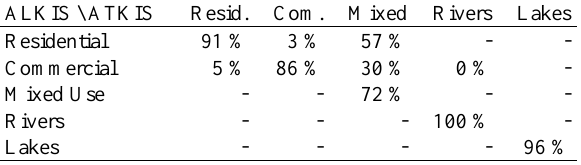
Table 2. Similarity matrix derived from the confusion matrix. The fields contain the percentage of the class combination referred to the lower frequent class.